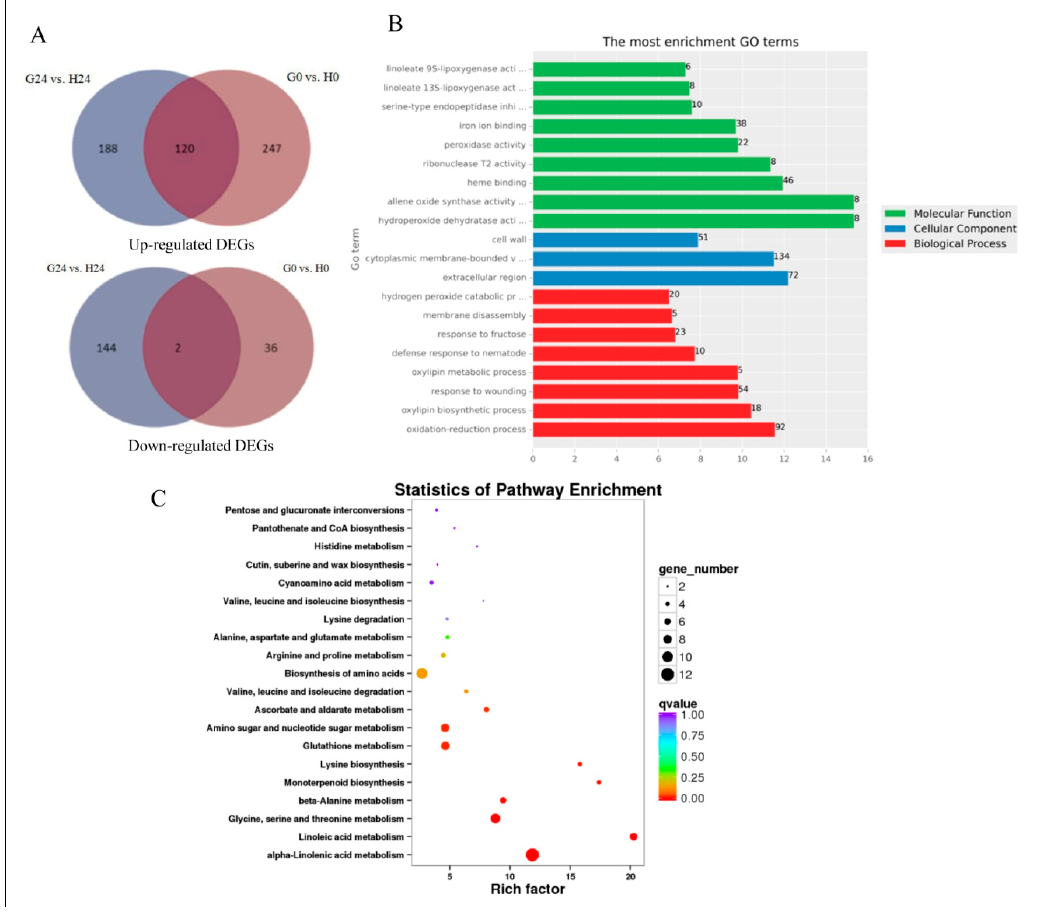
Figure 6. The DEGs in G24 vs. H24 groups. ( A ) DEGs overlapped in different groups comparison. ( B ) GO enrichment analysis of DEGs in G24 vs. H24 groups. ( C ) Statistical scatterplot showing the pathways enriched in genes differentially regulated in response to glycerol in the G24 vs. H24 groups. In the alpha-linolenic acid metabolism pathway, 1.13.11.12 identified as a lipoxygenase ( LOX2S ), eight DEGs identified as allene oxide synthase ( AOS , 4.2.1.92), and 5.3.99.6 identified as an allene oxide cyclase ( AOC ) were upregulated in the G24 pool compared with H24 pool. In the linoleic acid metabolism pathway (ko00591), six DEGs identified as linoleate 9S-lipoxygenase ( LOX1_5 , 1.13.11.58), and 1.13.11.12 identified as a lipoxygenase ( LOX2S ), were upregulated in the G24 pool compared